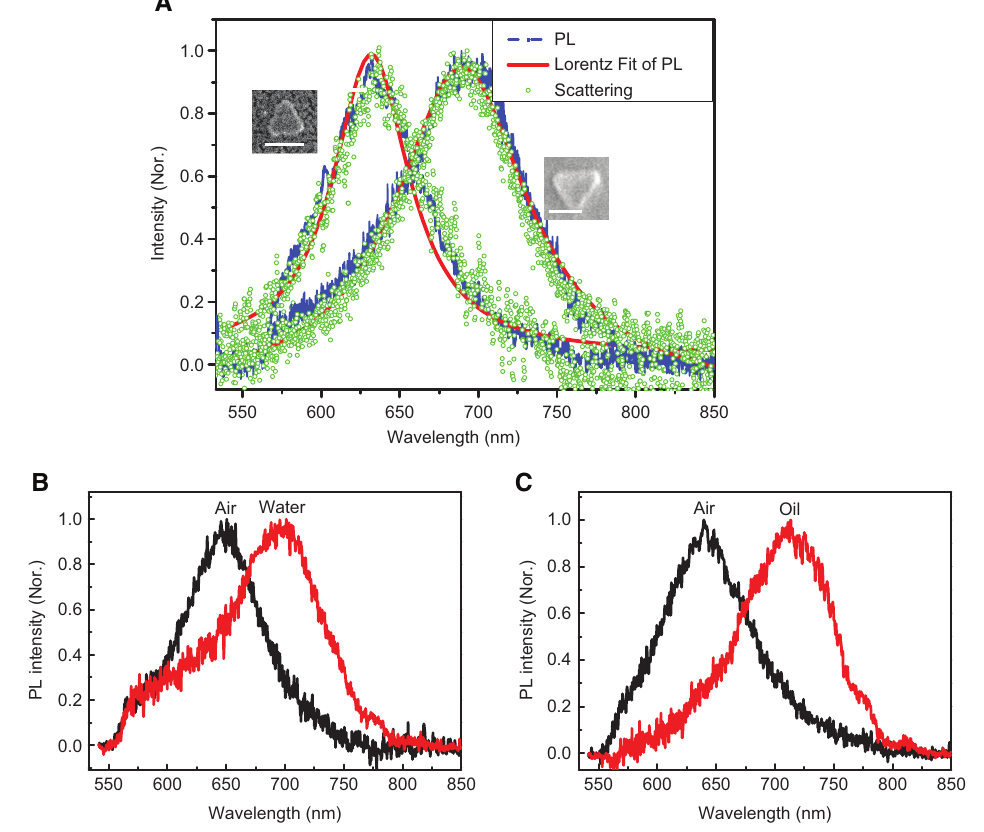
Figure 2: DF scattering and PL spectra of Ag TNPs. (A) Two typical DF scattering spectra (green scattered lines) and corresponding PL spectra (blue dashed lines) of two individual Ag TNPs with different sizes. The PL can be perfectly fitted by Lorentz functions (red solid lines). (B, C) The PL spectrum of an individual Ag nanoplate that was immobilized on a glass coverslip surrounded by air (black line) and water/oil (red